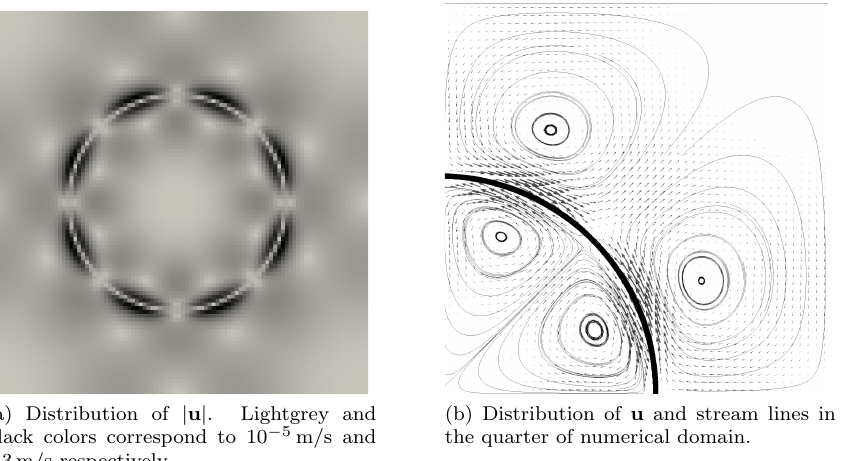
An impact of spurious currents is observed.